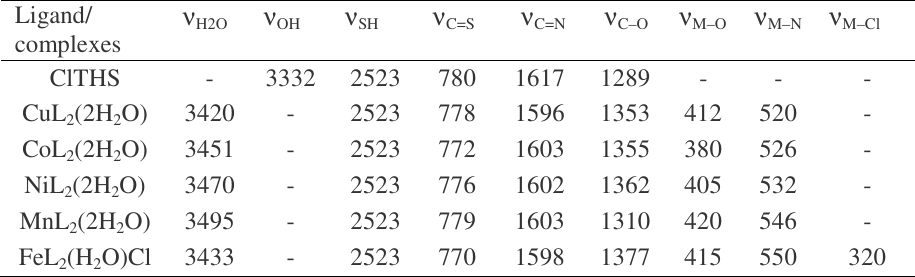
Table 3 .Characteristic IR frequencies (cm -1 ) of the ligand ClTHS and its complexes Ligand/